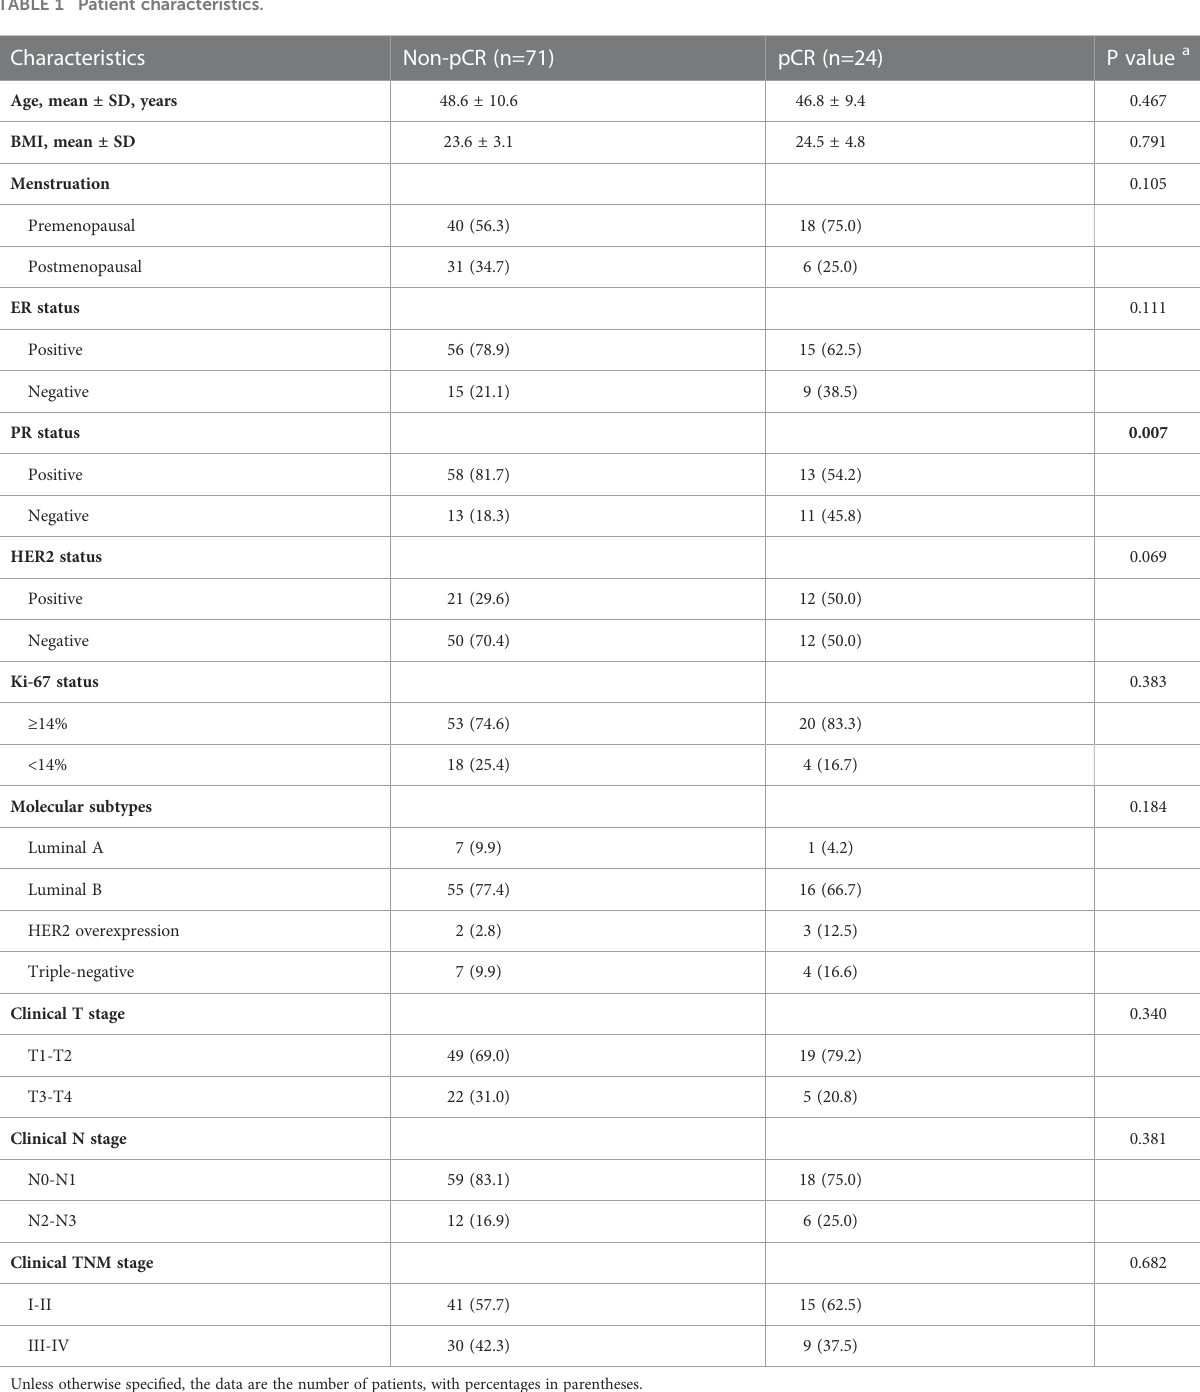
TABLE 1 Patient characteristics.